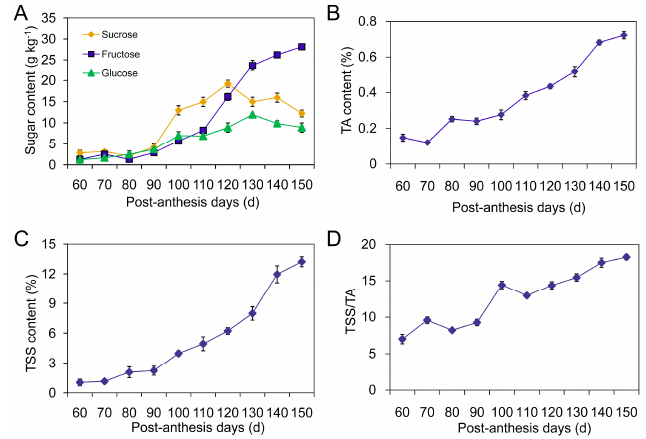
Figure 1. Changes in sugar components ( A ); titratable acidity (TA) ( B ); total soluble solids (TSS) ( C ) and TSS/TA ( D ) during development and ripening of loquat fruit. The presented data are the mean of three replicates (25 fruit samples each) from three experiments. Vertical bars, if larger than symbols, represent the standard errors of the mean ( n = 3).